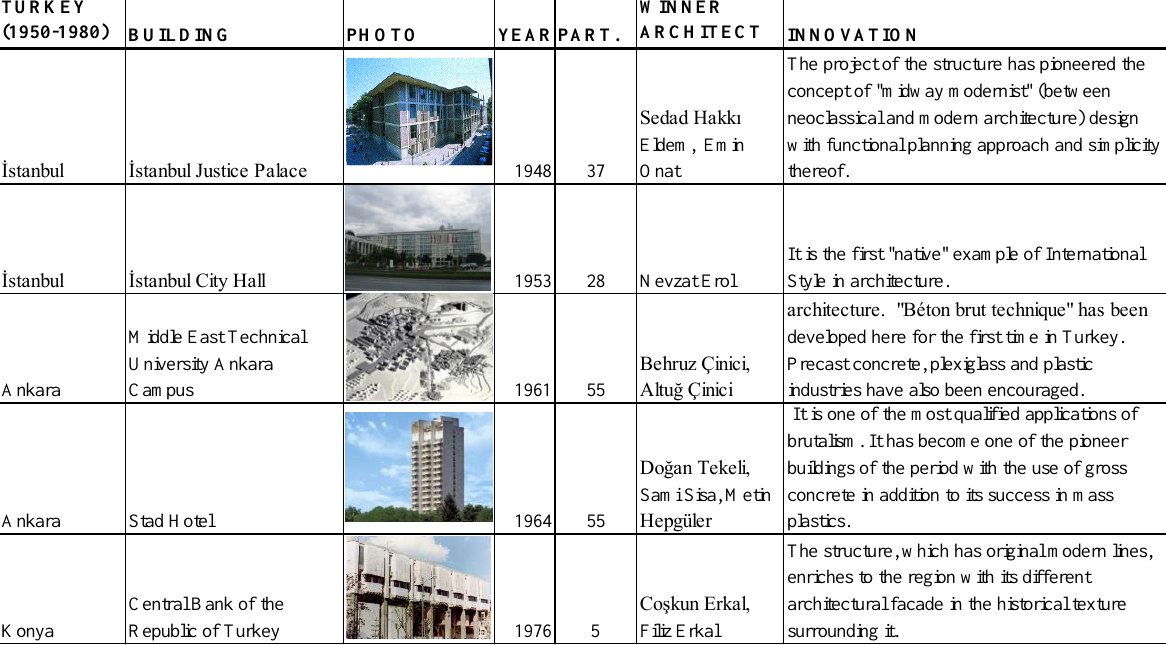
Table 7. Selected competition examples of 1950-1980 period TURKEY (1950-1980)